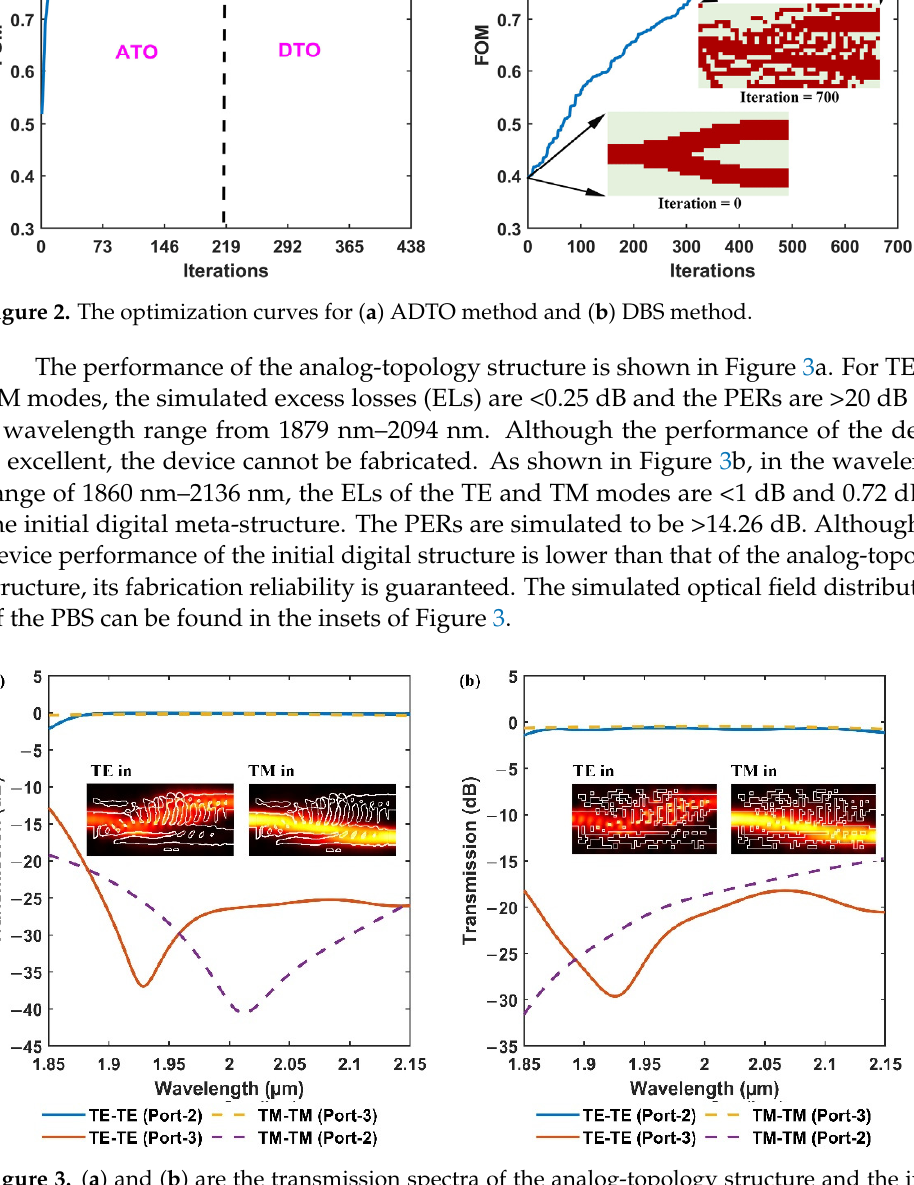
Figure 3. ( a ) and ( b ) are the transmission spectra of the analog-topology structure and the initial digital meta-structure, respectively.